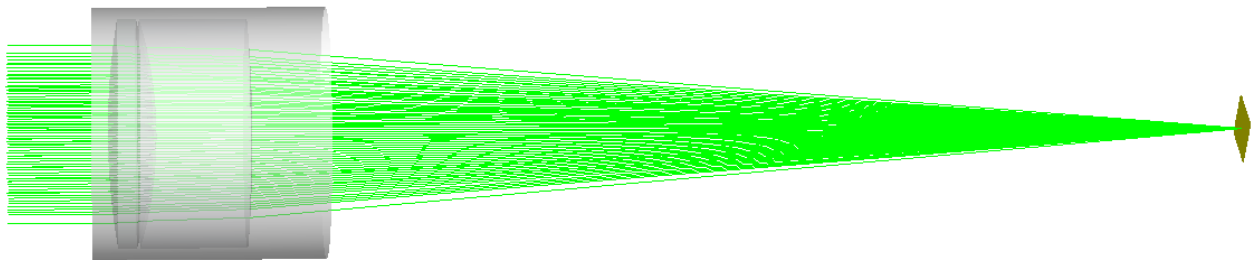
Figure A1. Optical layout of the LINOS 033486 laser focusing lens with a housing.